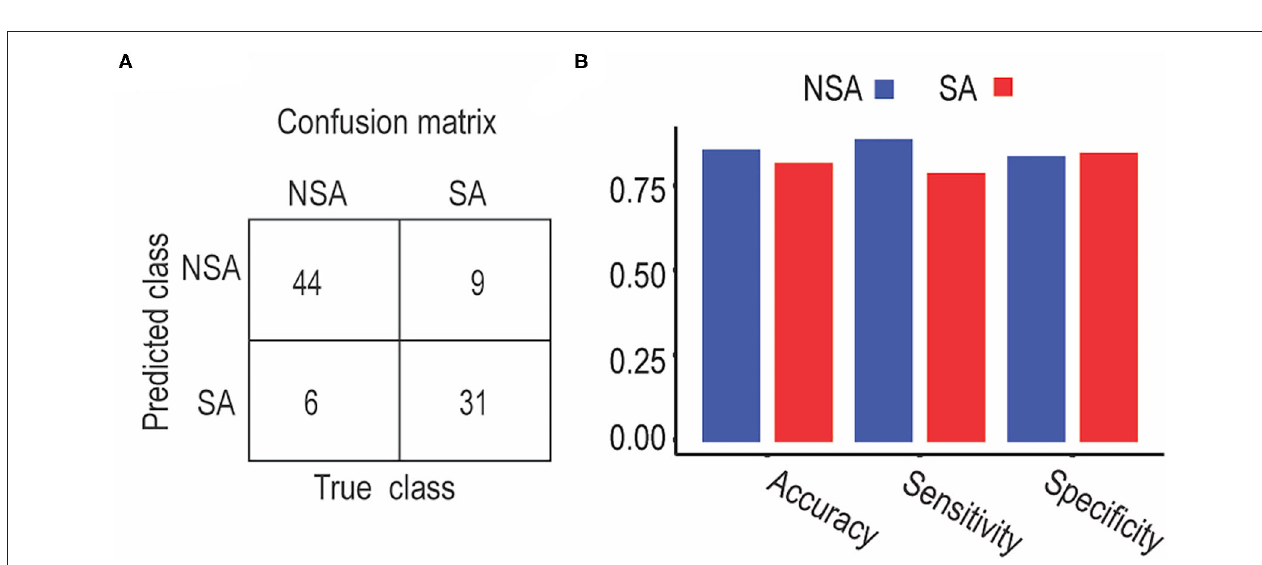
FIGURE 3 | Classification performance between SA and NSA patients using support vector machine. (A) Classification confusion matrices. Each row of the matrix represents the occurrences in an actual class, while each column represents the occurrences in a predicted class. (B) Classification accuracy, sensitivity, and specificity for NSA and SA,